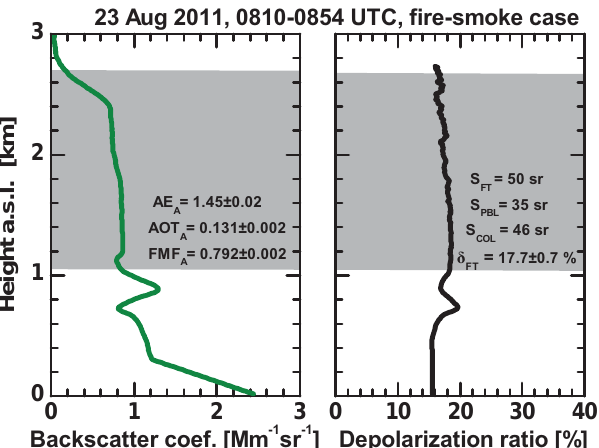
Figure 4. Same as Fig. 2, except for 23 August 2011. A fire smoke case is shown (i.e., air masses crossed fire areas over Turkey before reaching the lidar site). Retrieved values are given as numbers. Input in the lidar ratio retrieval is S PBL = 35sr.